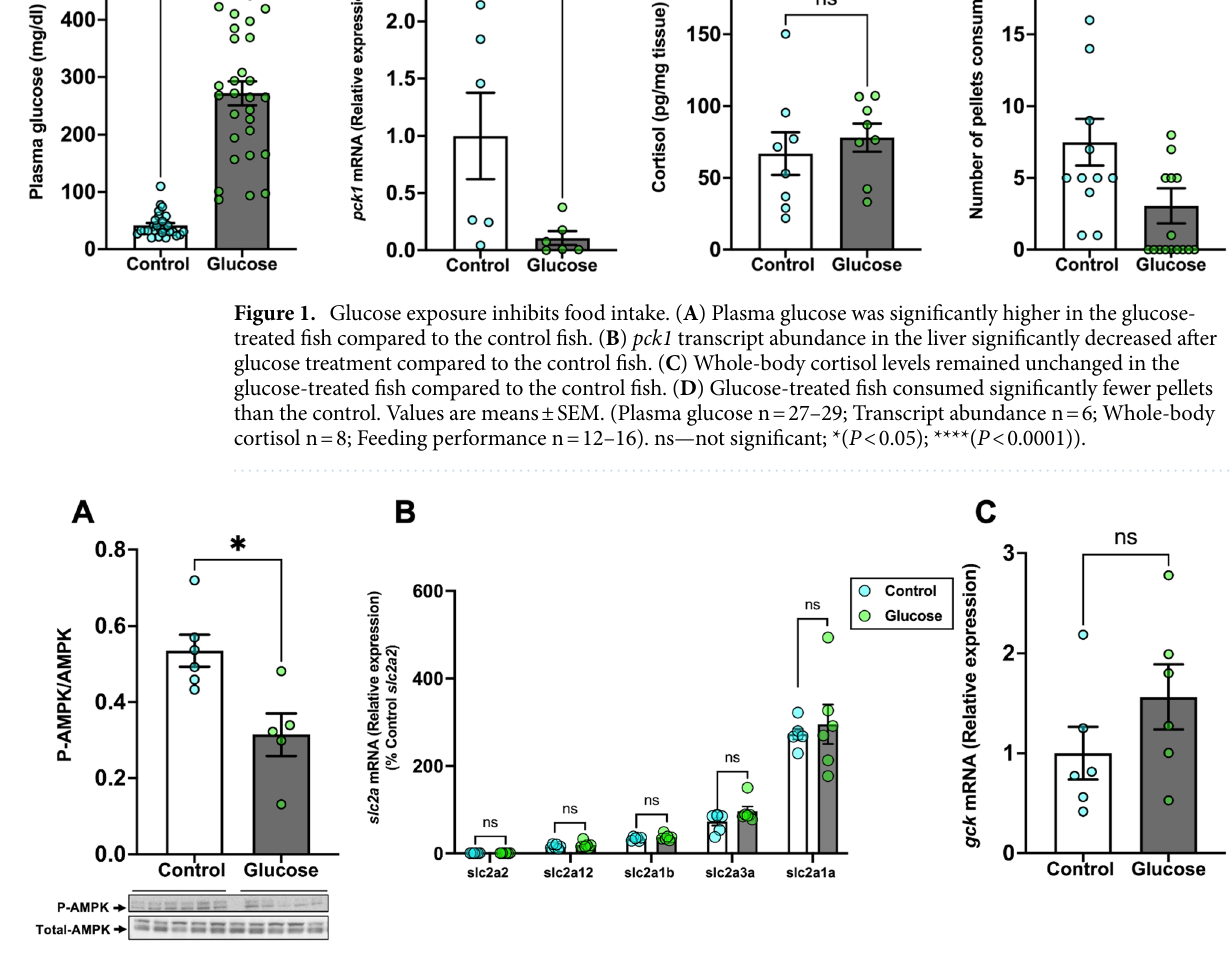
Fig. S1C; P = 0.21), mc3r (Supplemental: Fig. S1D; P = 0.836, mc4r (Supplemental: Fig. S1E; P = 0.246), and lepa (Supplemental: Fig. S1F; P = 0.653) were not significantly different in the glucose-treated fish compared to the control fish.